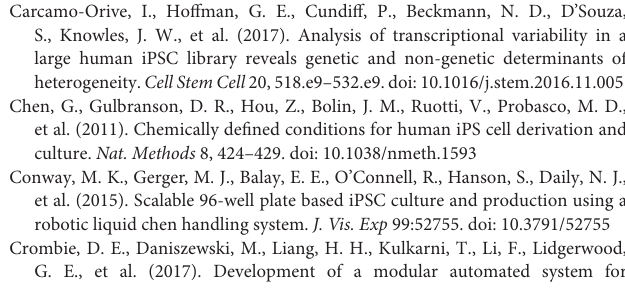
Supplementary Figure 2 | Automated splitting based on well-specific confluency vs. plate-specific confluency. Survival plot based on 24 hiPSC clones propagated for 10 consecutive passages in the StemCellFactory using either well-specific or plate-specific dilution ratios for passaging. Well-specific dilution ratios were calculated based on the confluence of each individual well; the plate-specific dilution ratio based on the confluence of the most confluent well of the 24-well plate. Supplementary Figure 3 | Pluripotency and SNP analysis of automatically reprogrammed hiPSCs. Shown are 5 distinct hiPSC clones generated from 2 independent donors. HiPSCs were analyzed at passages 10-12 upon confirmation of transgene elimination. (A) Genetic integrity was assessed by SNP genotyping. For each chromosome the B allele frequency (upper row) and the log R ratio (lower row) are shown. The SNP analysis of two clones from donor 1 depicts copy number variations (CNVs) in chromosomes 1q and 18q (clone 1) as well as 20q (clone 2) highlighted with red boxes, which were not present in the parental fibroblast population (data not shown) and might be caused by a low-grade mosaicism in the fibroblast source cells or by an in vitro selection of mutations acquired during the reprogramming and cell culture process. (B) Pluripotency was assessed using the Epi-Pluri-Score (Cygenia GmbH, Aachen), which is an epigenetic pluripotency biomarker assay based on DNA methylation (DNAm) levels at three specific CpG sites: The Epi-Pluri-Score combines genomic DNA methylation levels at the two CpG sites ANKRD46 and C14orf115, defined as: β -value [ANKRD46] – β -value [C14orf115]. A positive Epi-Pluri-Score indicates pluripotency (Lenz et al., 2015). The third CpG site is located within the pluripotency gene POU5F1 (OCT4) and shows a DNA methylation level of > 0.4 in non-pluripotent cells. Supplementary Figure 4 | High-speed microscopy and deep learning algorithm-based morphological analysis of hiPSCs (Module 4). High-speed microscope for image acquisition and morphological assessment of the hiPSCs in 6-well plates. Image acquisition is performed by stroboscopic flashing directly from a moving microscopic stage. (A) Nikon, TI-E microscope upgraded by the Fraunhofer IPT for high-speed, whole well imaging acquisition. (B,C) Exemplary classification of the acquired images (hiPSC classification: black = cell free area, gray = hiPSCs, red = differentiated cells, purple = dead cells (examples are encircled), green circumference = open border of a colony, blue circumference = enclosed border of a colony. Supplementary Figure 5 | Data-driven workflow for automated cultivation and quality control of hiPSCs in the StemCellFactory. Microscopic data and turbidity measurements for quality control assessed during the on-going expansion of hiPSCs are used for decision making on whether cells (1) are incubated further, (2) need a medium change, (3) need to be passaged at a certain ratio or (4) should be discarded due to contamination or bad cell quality. Transport steps to the concerning modules are indicated in green boxes. Decision steps are indicated in light blue diamond-shaped boxes (comparator evaluation). Supplementary Movie 1 | StemCellFactory